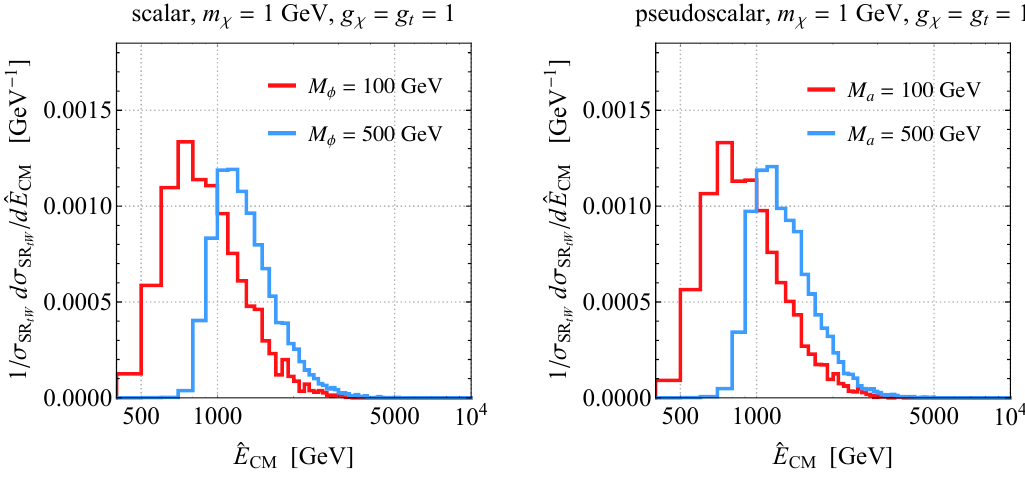
Figure 2 . Normalised di(cid:11)erential (cid:12)ducial cross sections for tW + E miss of the partonic CM energy in the scalar (left) and pseudoscalar (right) s -channel DM simpli(cid:12)ed model. The shown predictions correspond to 14 TeV pp collisions, the selections SR tW de(cid:12)ned in table 1 and the parameter choices indicated in the legends and the headlines of the two panels.